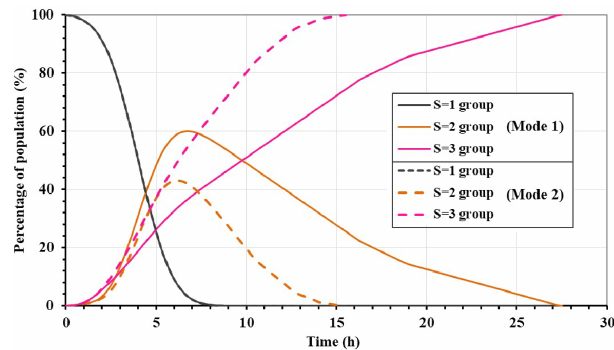
Figure 14. Comparison of residents’ evacuation processes for the two route-searching strategies (note that all five evacuation shelters are selected for the two scenarios, and the variation in residents’ evacuation preparation times is